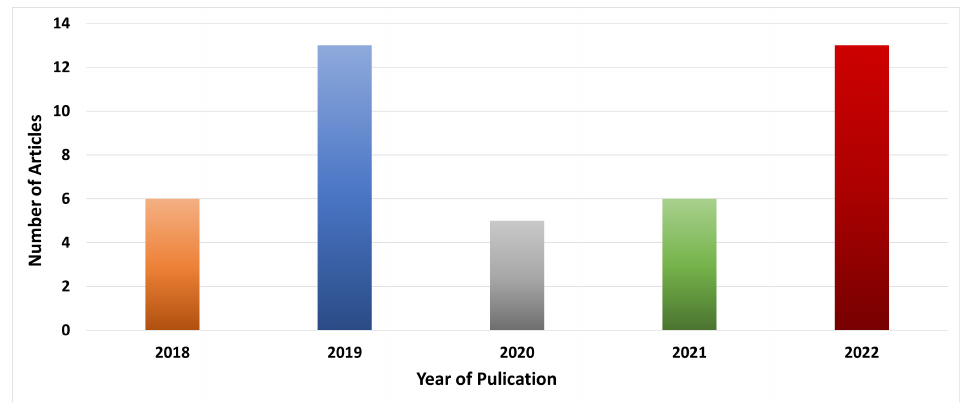
Figure 4. Distribution of the number of published articles by year of publication. Table 1. Primary Information of the Included